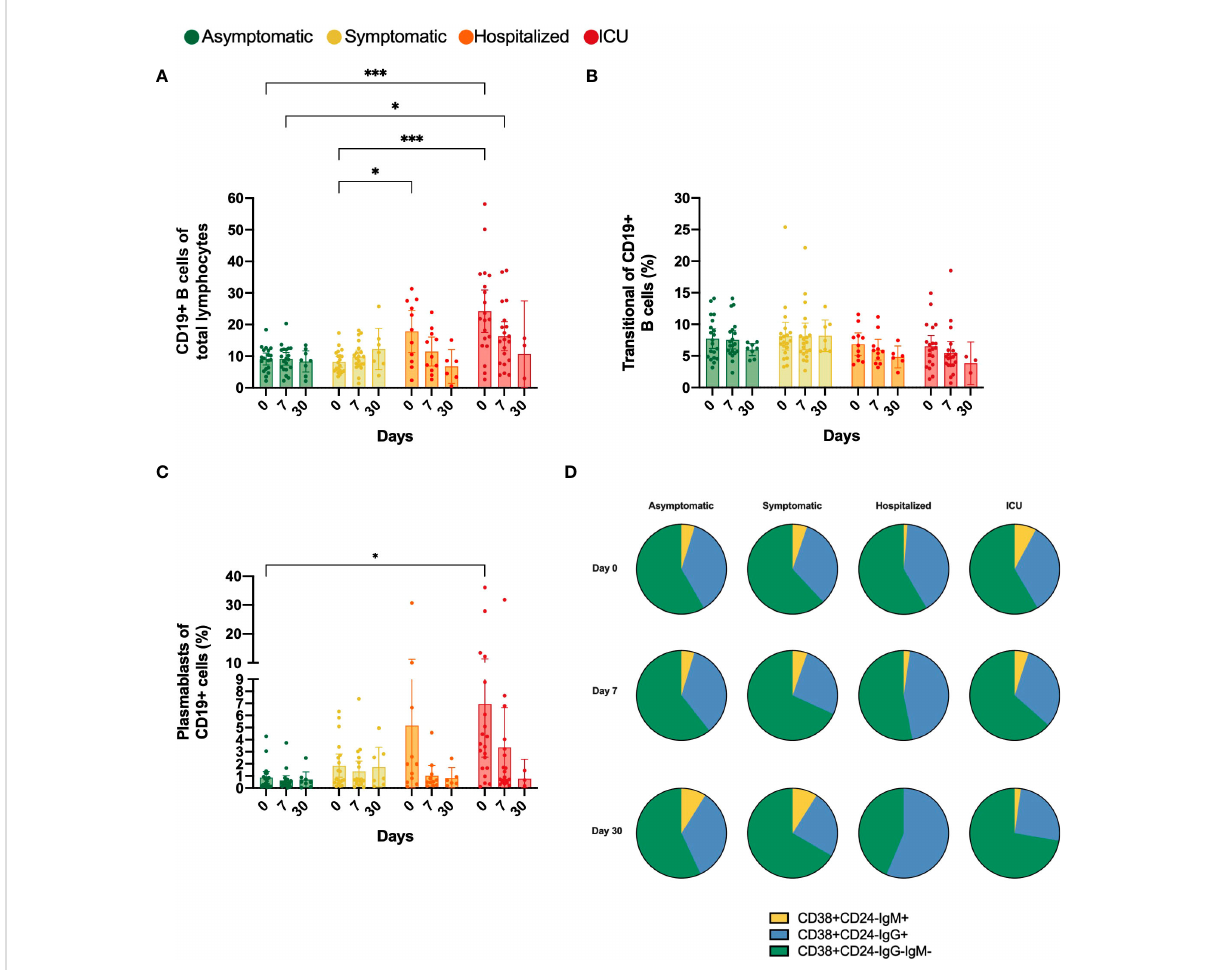
FIGURE 3 Percentage of CD19 + , transitional and plasmablasts (PB) B cells and proportion of IgM + , IgG - and IgG - IgM - plasmablasts. Bar charts illustrate the percentage of (A) CD19 + cells, (B) Transitional and (C) PB cells, represented by mean and con fi dence interval (CI, 95%). (D) Parts of whole diagrams depict the proportion of either IgM + , IgG + or IgM - IgG - expression in the PB population. All graphs represent asymptomatic, symptomatic, hospitalized, and ICU groups on days 0, 7 and 30 after recruitment. Data were analyzed using a mixed-effects model with the Geisser-Greenhouse correction with Tukey ’ s multiple comparisons testing between groups. A p-value < 0.05 was considered signi fi cant. *p < 0.05, ***p <